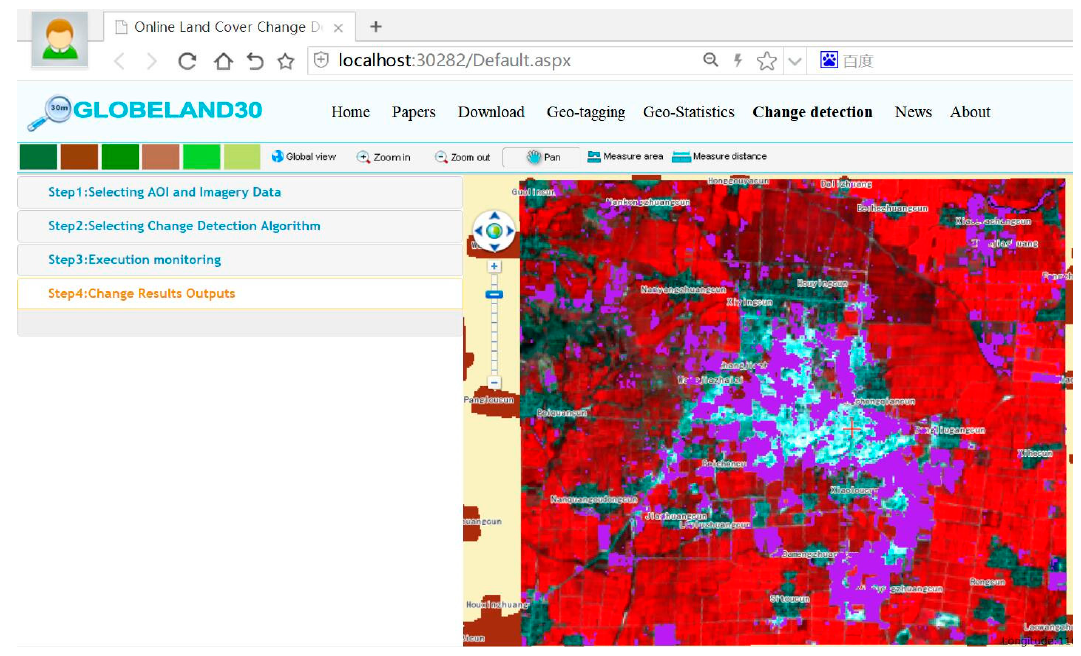
Figure 10. Change detection results (purple regions) visualized using a web map service (WMS).